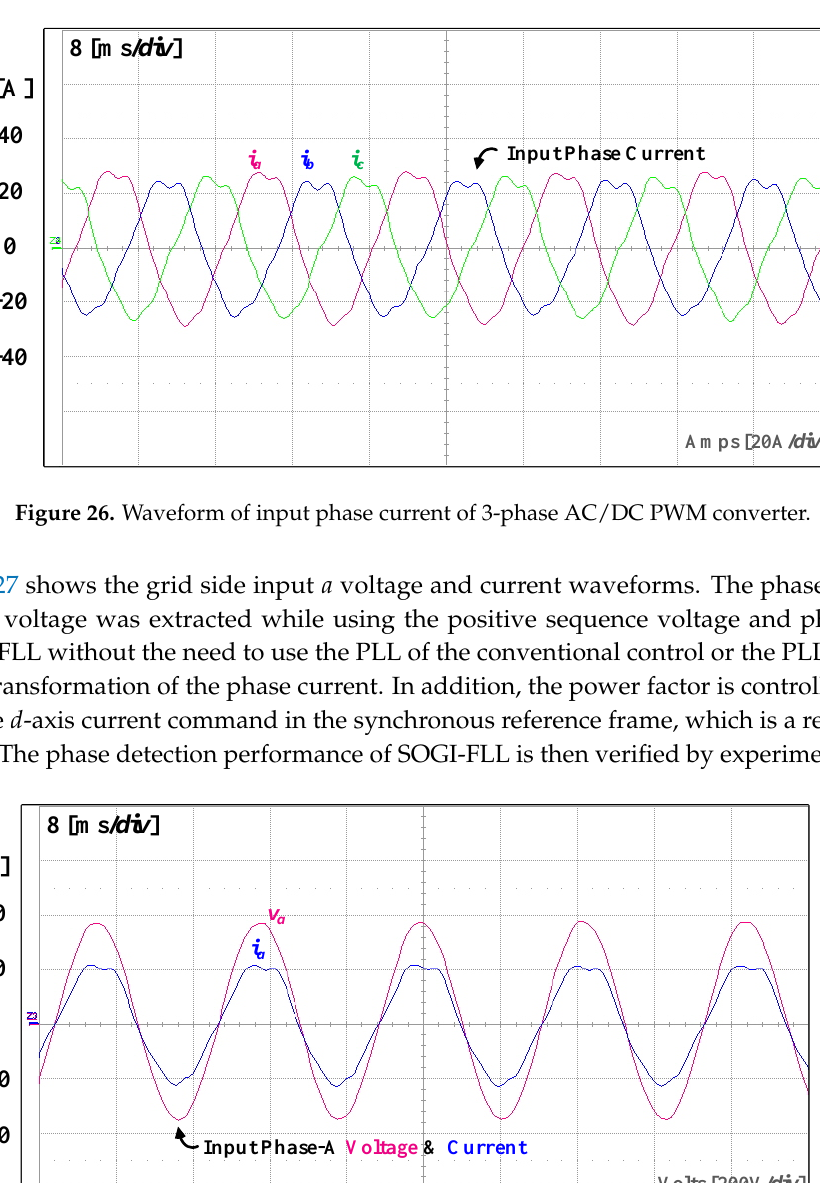
Figure 27. Waveform of input phase a voltage and current.